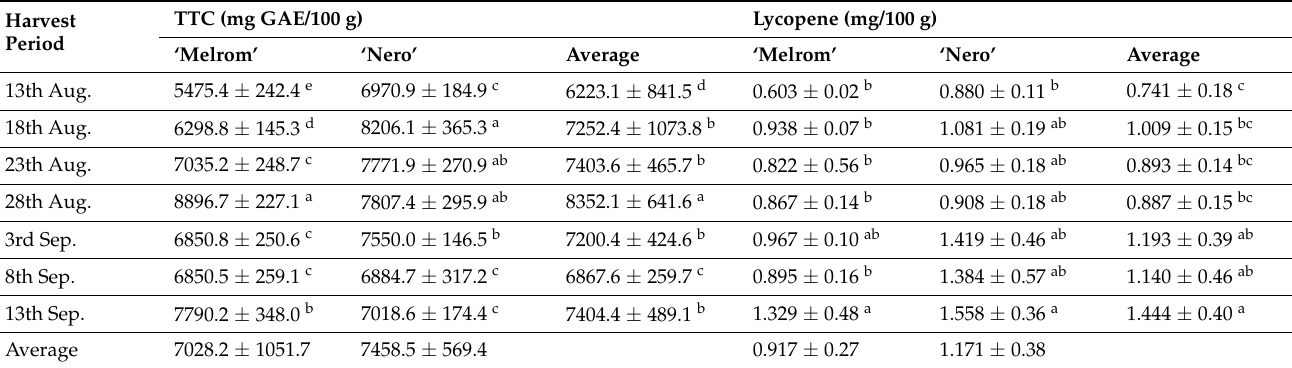
Table 3. Variations in total tannins content (TTC) and the lycopene content in dehydrated chokeberry pomace during the harvest season *.